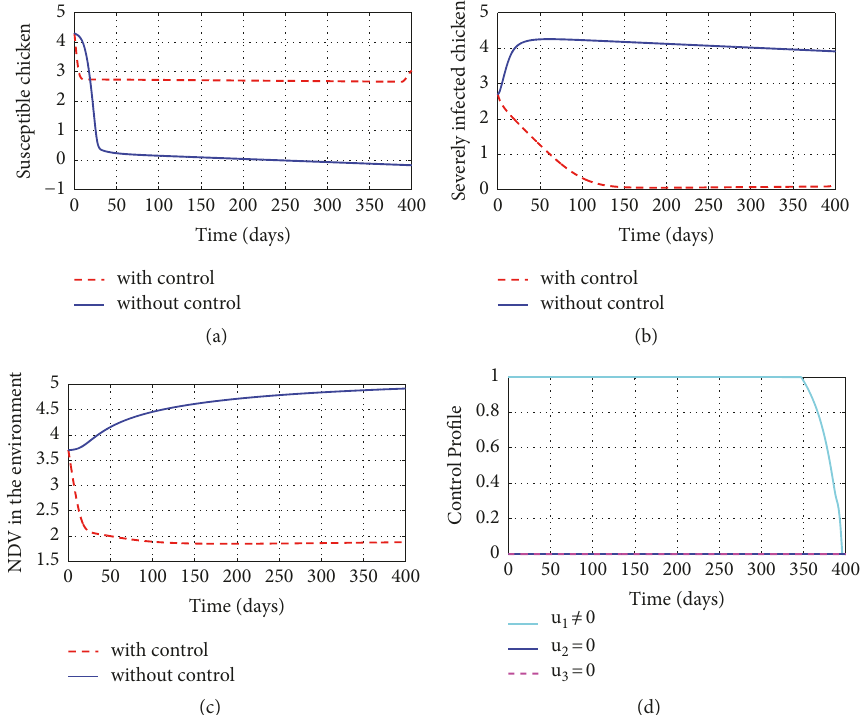
Figure 2: Optimal solutions for model variables 𝑆 𝑐 , 𝐼 𝑐 , 𝐻 and the control profiles for 𝑢 1 , 𝑢 2 , 𝑢 3 with ( 𝑢 1 ̸= 0 , 𝑢 2 = 0 , 𝑢 3 = 0 ).